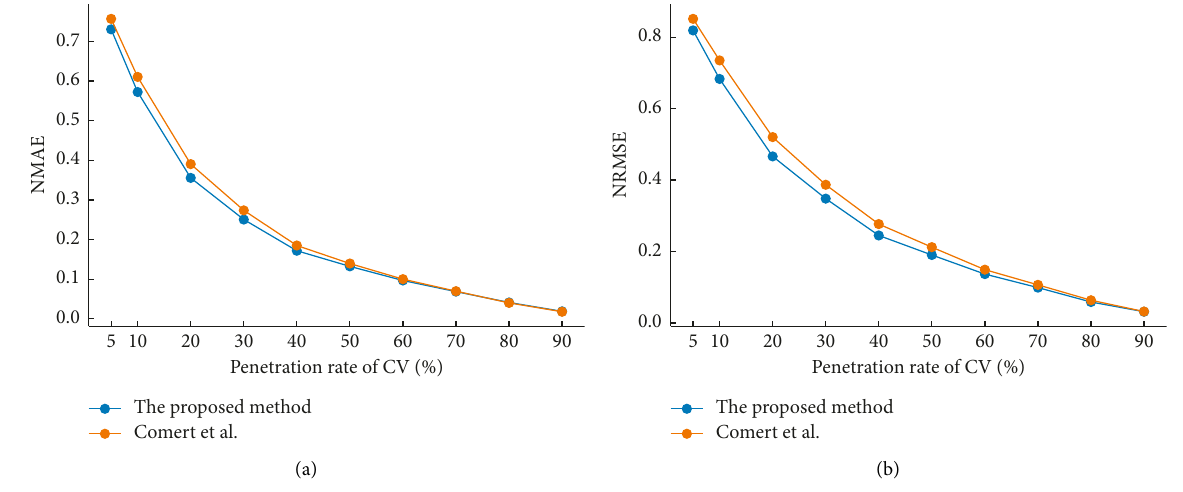
Figure 11: Comparison of different methods. (a) NMAE. (b)